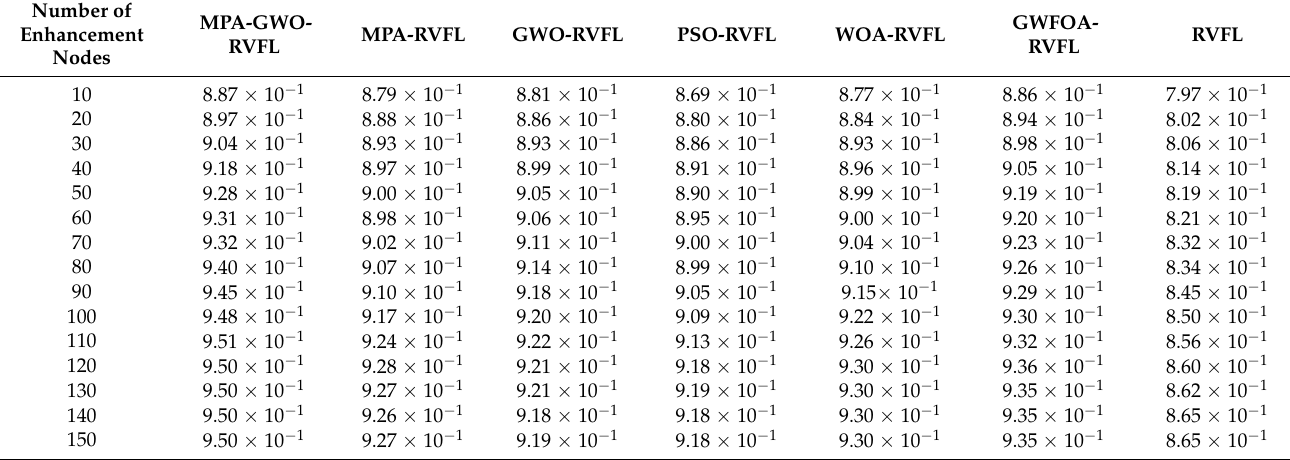
Table A3. Influence of node number on prediction